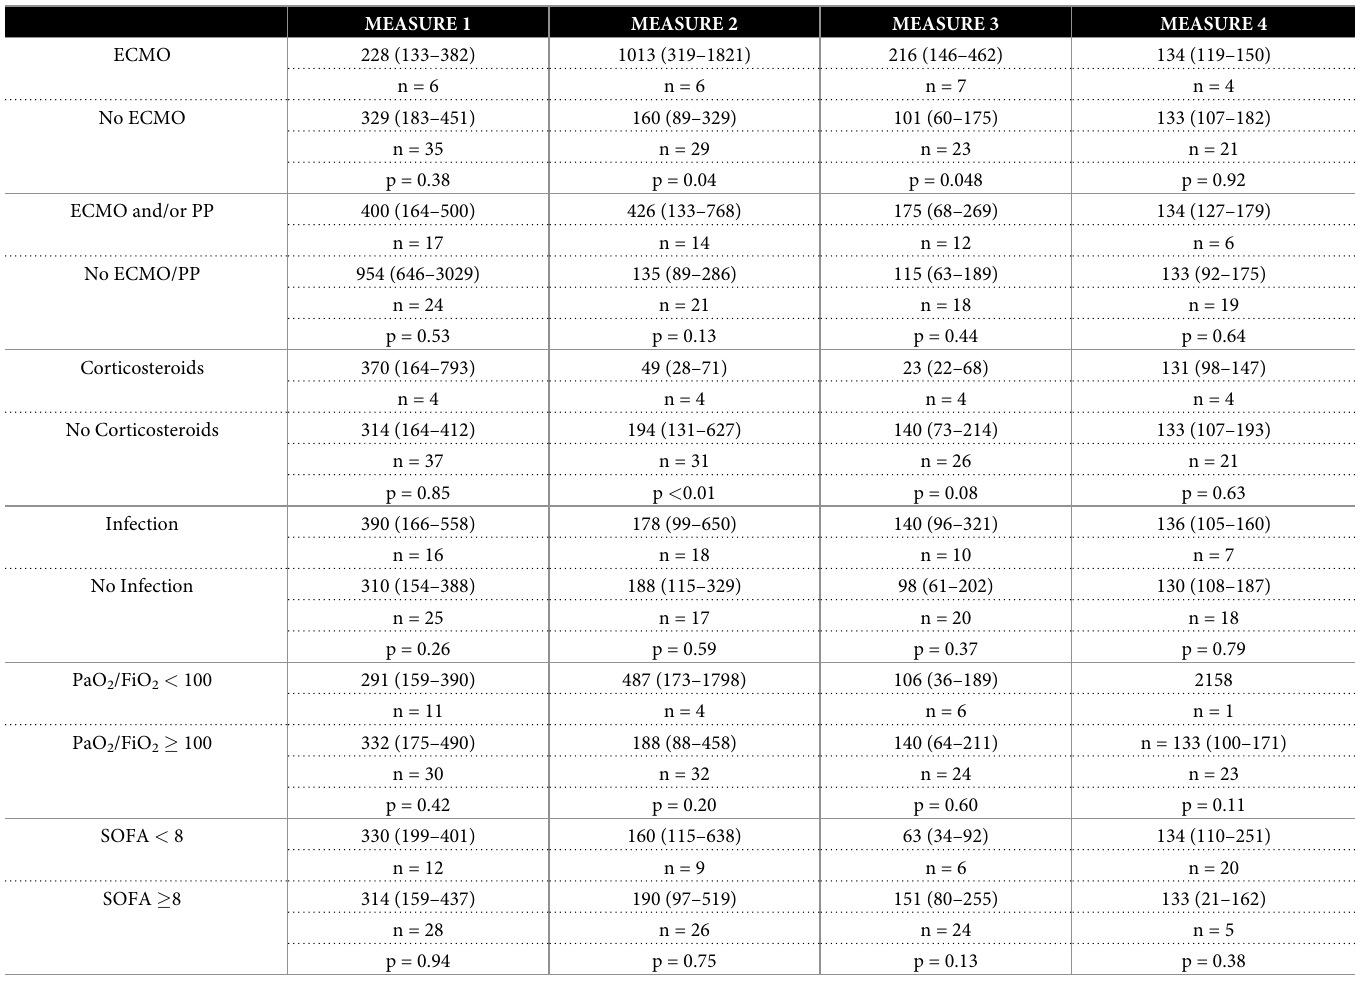
Table 3. IL-6 levels in different subgroups of